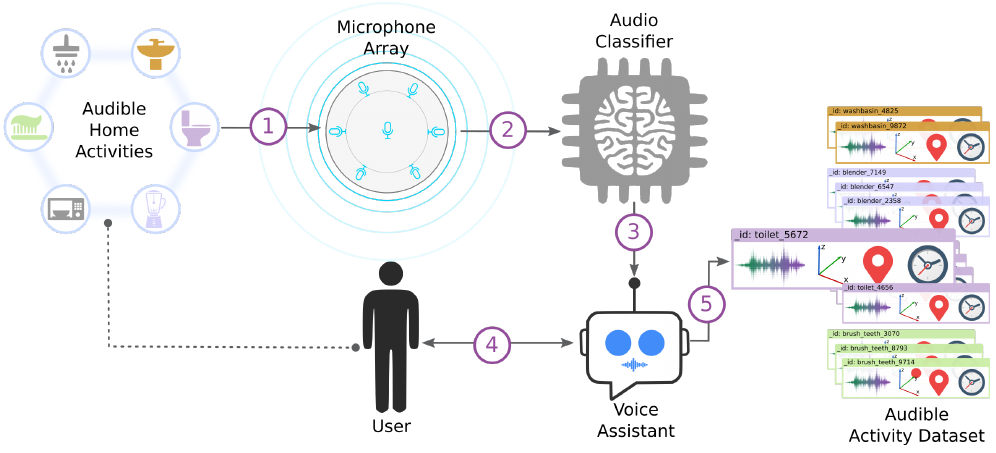
Figure 6. Overview of the functionality of Intelligent System for Sound Annotation